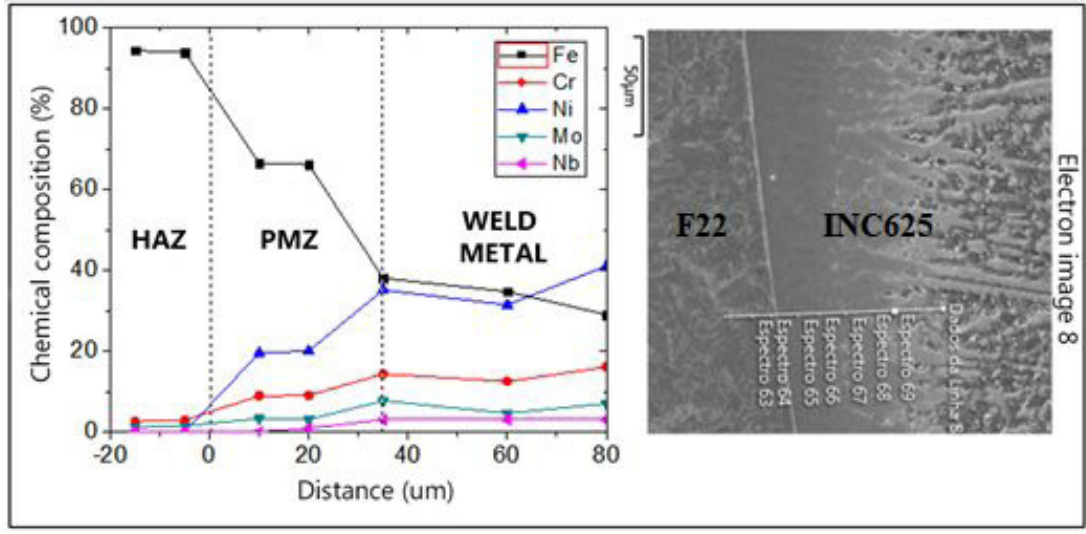
Figure 4. Chemical profile through F22/INC625 interface.